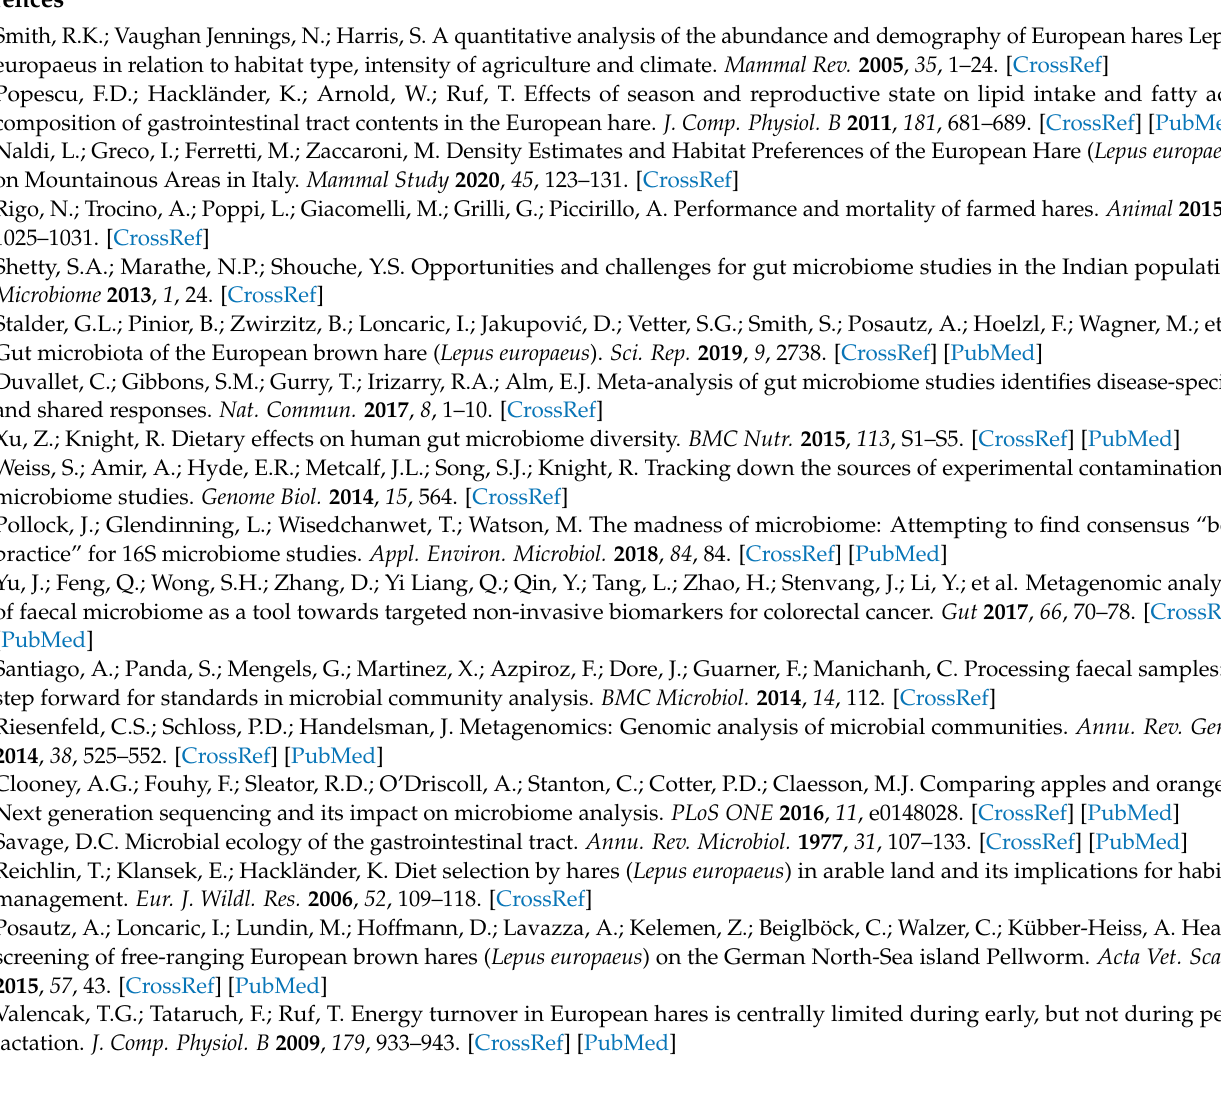
control samples. Table S2: Table showing the percentage of the most abundant bacteria phyla in experimental